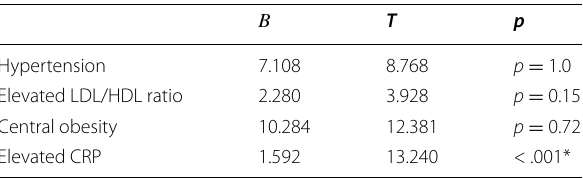
Table 6 Linear regression for prediction of Log childhood trauma symptom dimension